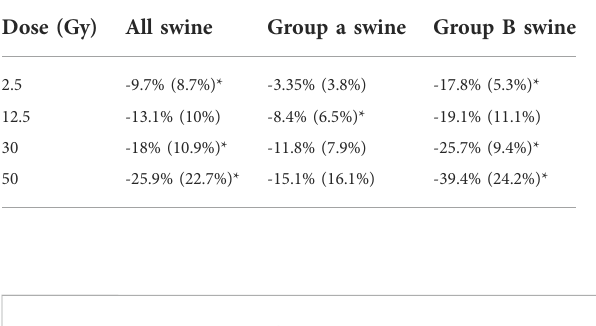
TABLE1Summaryofpercentchangesinvesselvolume.Valuesintable are entered as average (standard deviation) of the 10 swine (all swine) or of the fi ve swine (Group A or Group B). Statistically signi fi cant values ( p < 0.05) are denoted with a *.